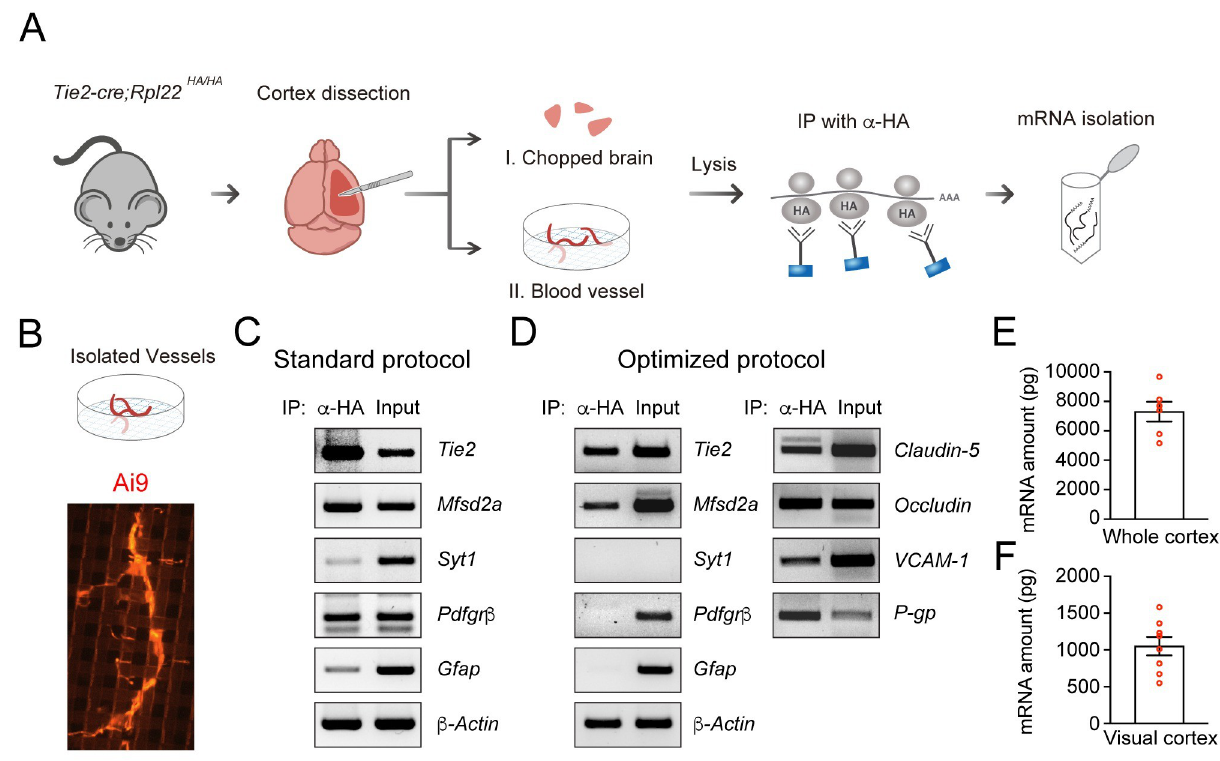
Fig 2. Comparative analysis of the conventional RiboTag method and our new RiboTag protocol. (A) Workflow diagram and validation of the RiboTag method. (B) Images of vessels isolated with a cell strainer (40 μ m) before the immunoprecipitation step. (C, D) RT–PCR to verify the BEC specificity of mRNA pools isolated by the standard RiboTag protocol (C) and by our optimized RiboTag protocol (D). Brain endothelial cell markers: Tie2 , Mfsd2a , Claudin-5 , Occludin , VCAM-1 , P-gp , neuronal cell marker: Syt1 , astrocyte marker: Gfap , and pericyte marker: Pdgfr β . The amount of mRNA isolated from the whole cortex (7.3 ± 0.668 ng) (E) and the visual cortex (1.05 ± 0.125 ng) (F) . Mean ± SEM; n = 6 for the whole cortex, n = 8 for the visual